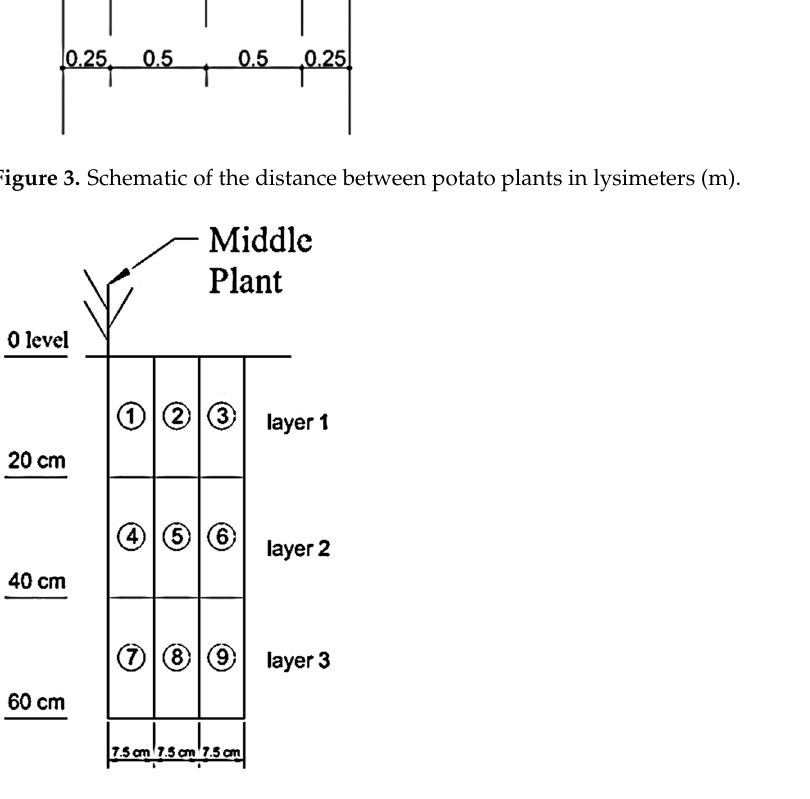
Figure 4. Schematic (2D vertical cross section) showing positions of the collected soil samples in each lysimeter at the end of the experiment.